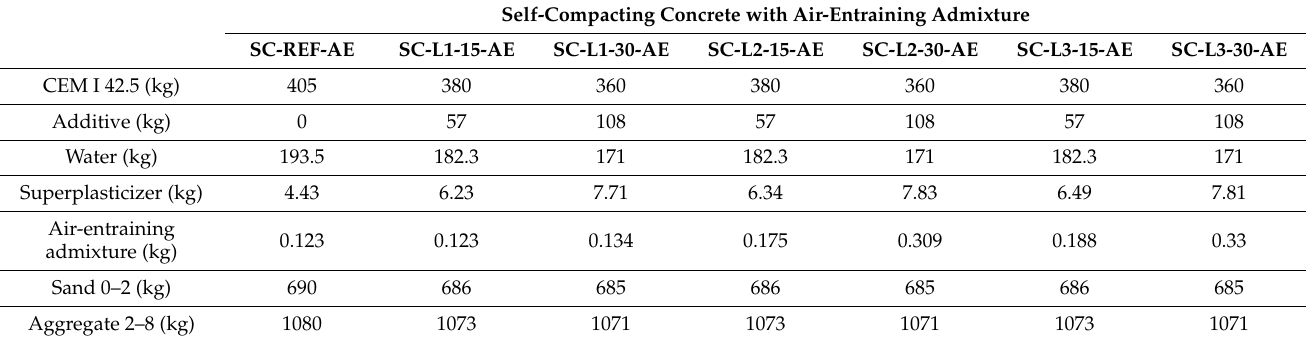
Table 5. Composition of 1 m 3 of self-compacting concrete with air-entraining